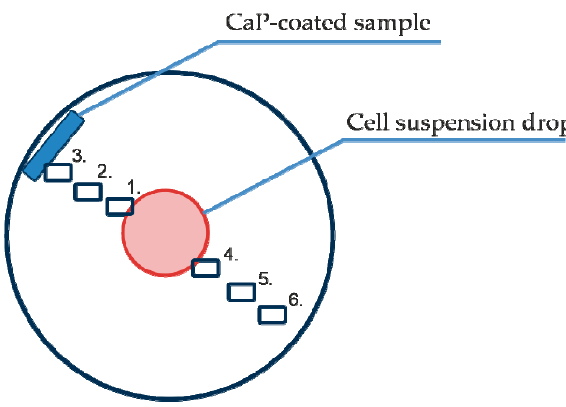
Figure 1. Scheme of cell migration imaging points 01–06 relative to the primary cell suspension and the test samples with calcium phosphate (CaP) coating.